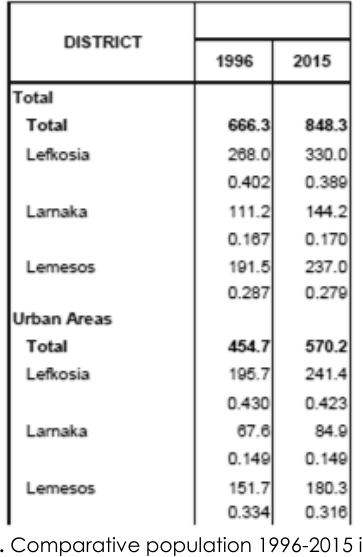
Figure 255. Comparative population 1996-2015 in Cyprus. Source: Statistical Service of Cyprus (CYSTAT).